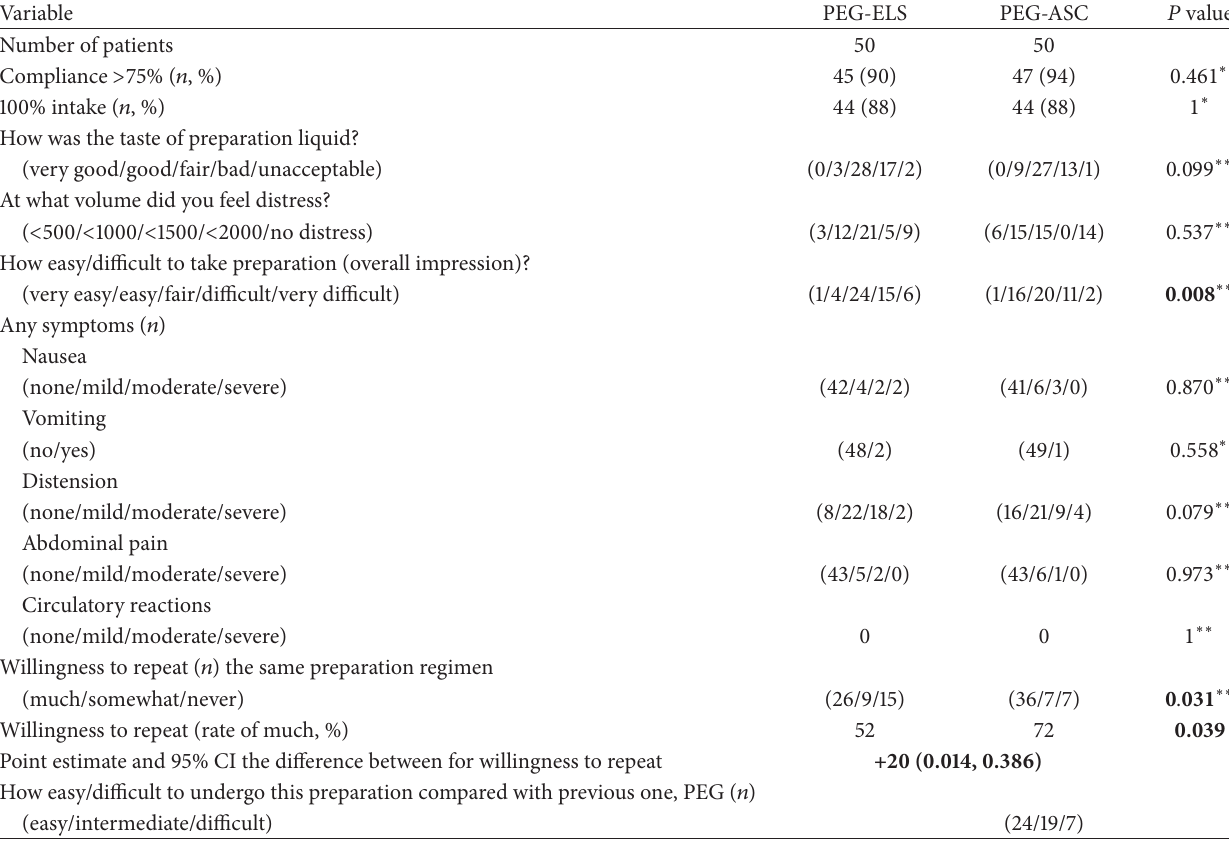
Table 2: Patient tolerance and acceptance.